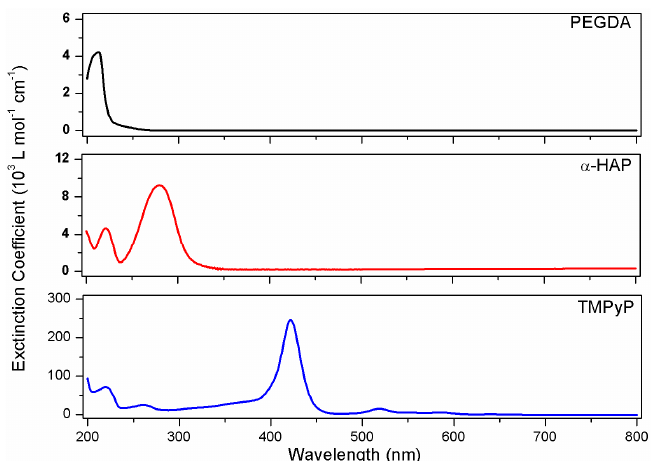
Figure 2. Extinction coefficients of poly(ethylene glycol) diacrylate (PEGDA) (10 − 3 mol · L − 1 ), α -HAP (10 − 5 mol · L − 1 ), and TMPyP (2.5 × 10 − 6 mol · L − 1 ) in deionized water.